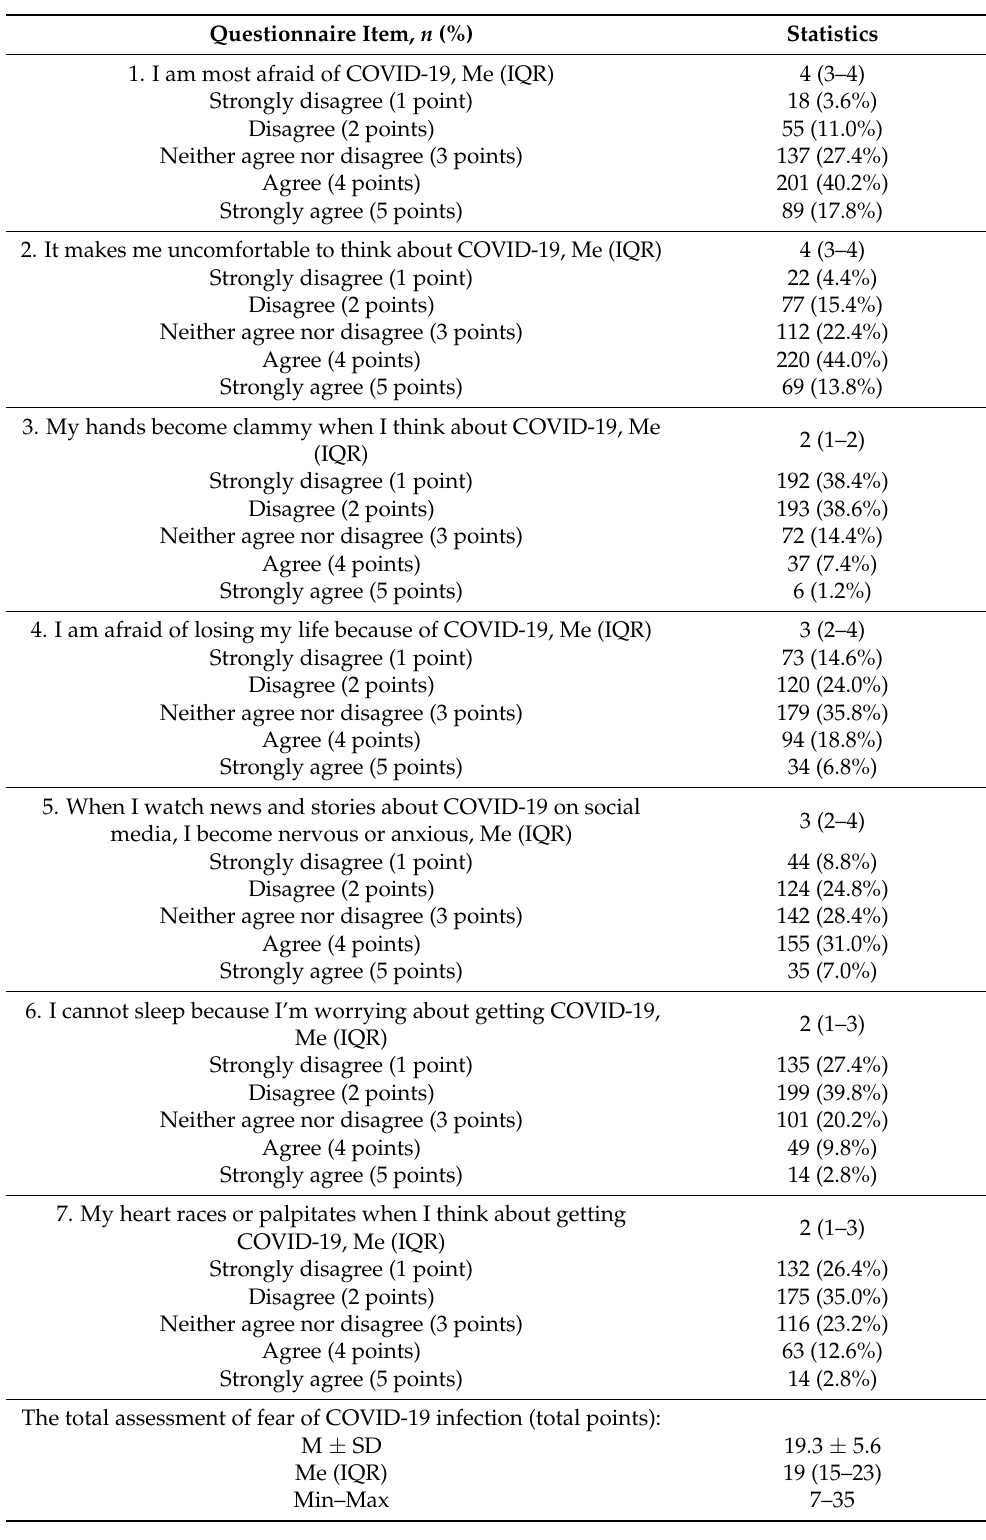
Table 1. Assessment of fear of COVID-19 infection, based on